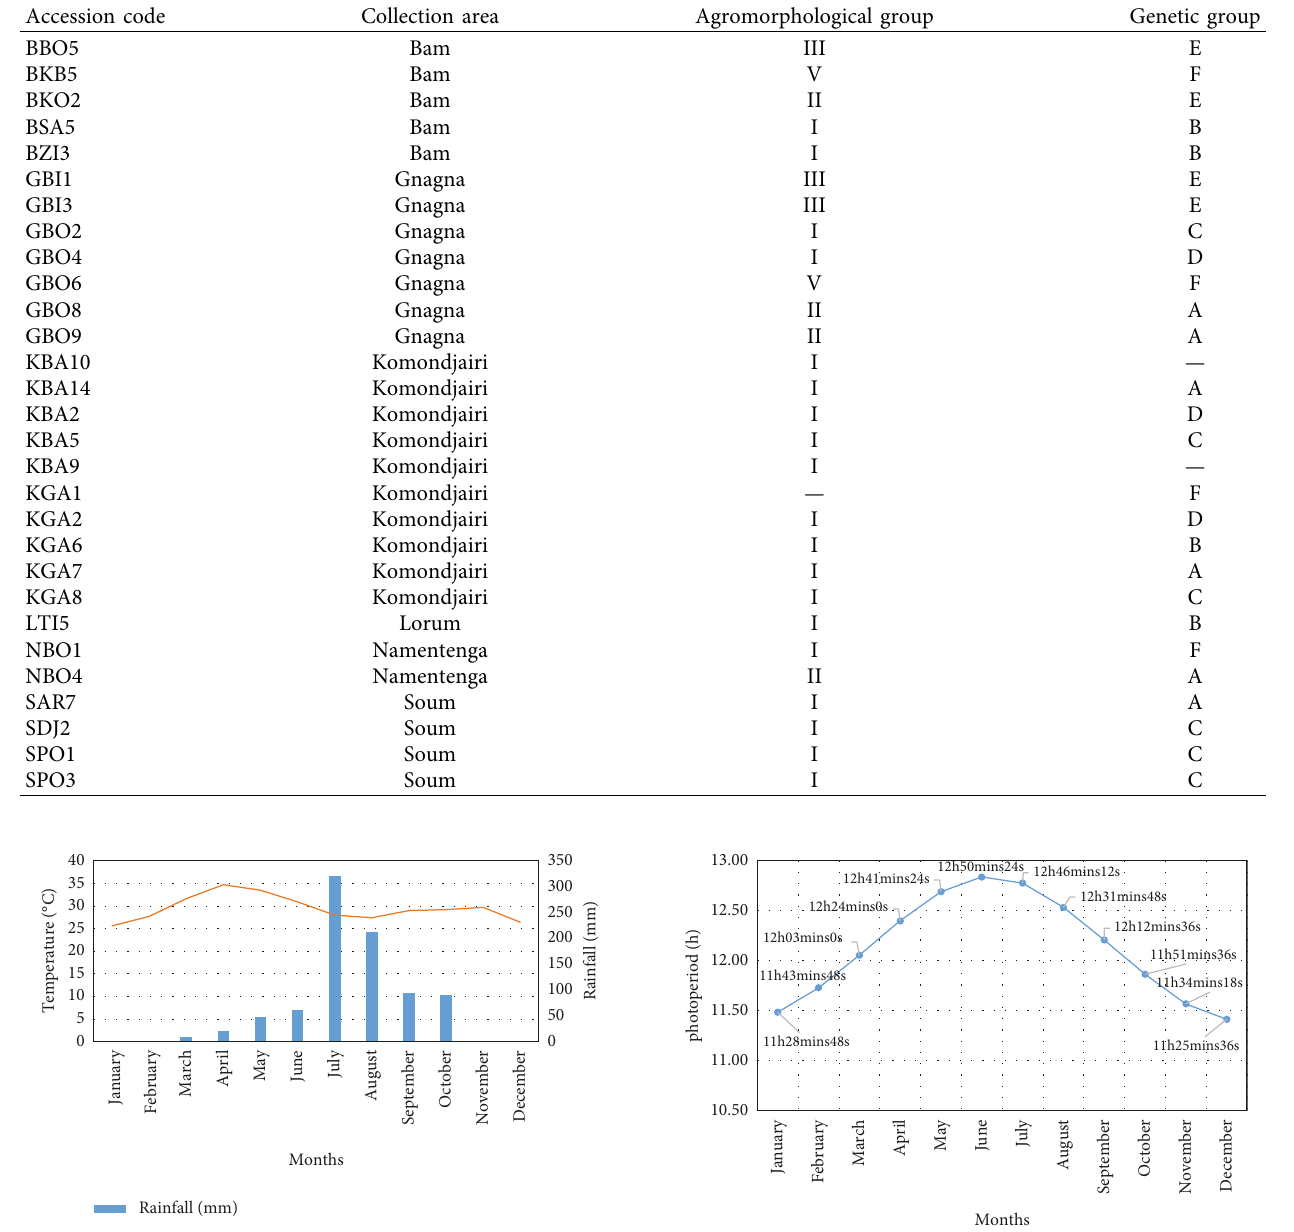
Table 1: List of the 29 accessions of sweet sorghum.